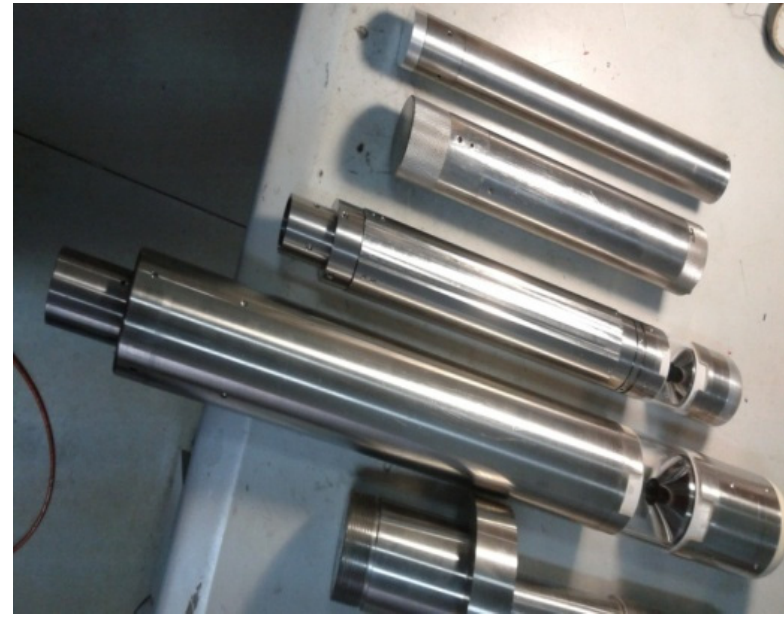
Figure 1. Panoramic borehole camera